Question: Condense the content of this figure into a single sentence.
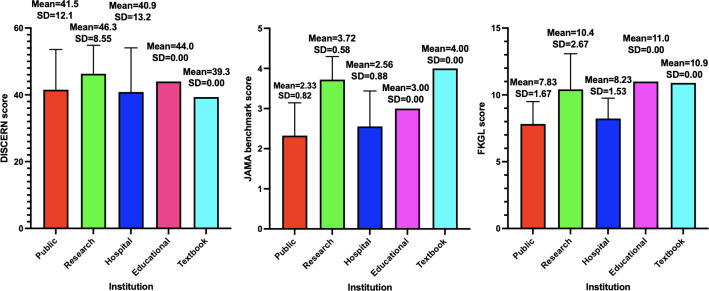
Answer: Graphical representation of the means and SDs of DISCERN, Journal of the American Medical Association (JAMA) benchmark and Flesch-Kincaid Grade Level (FKGL) scores based on the institutional origin of the website.